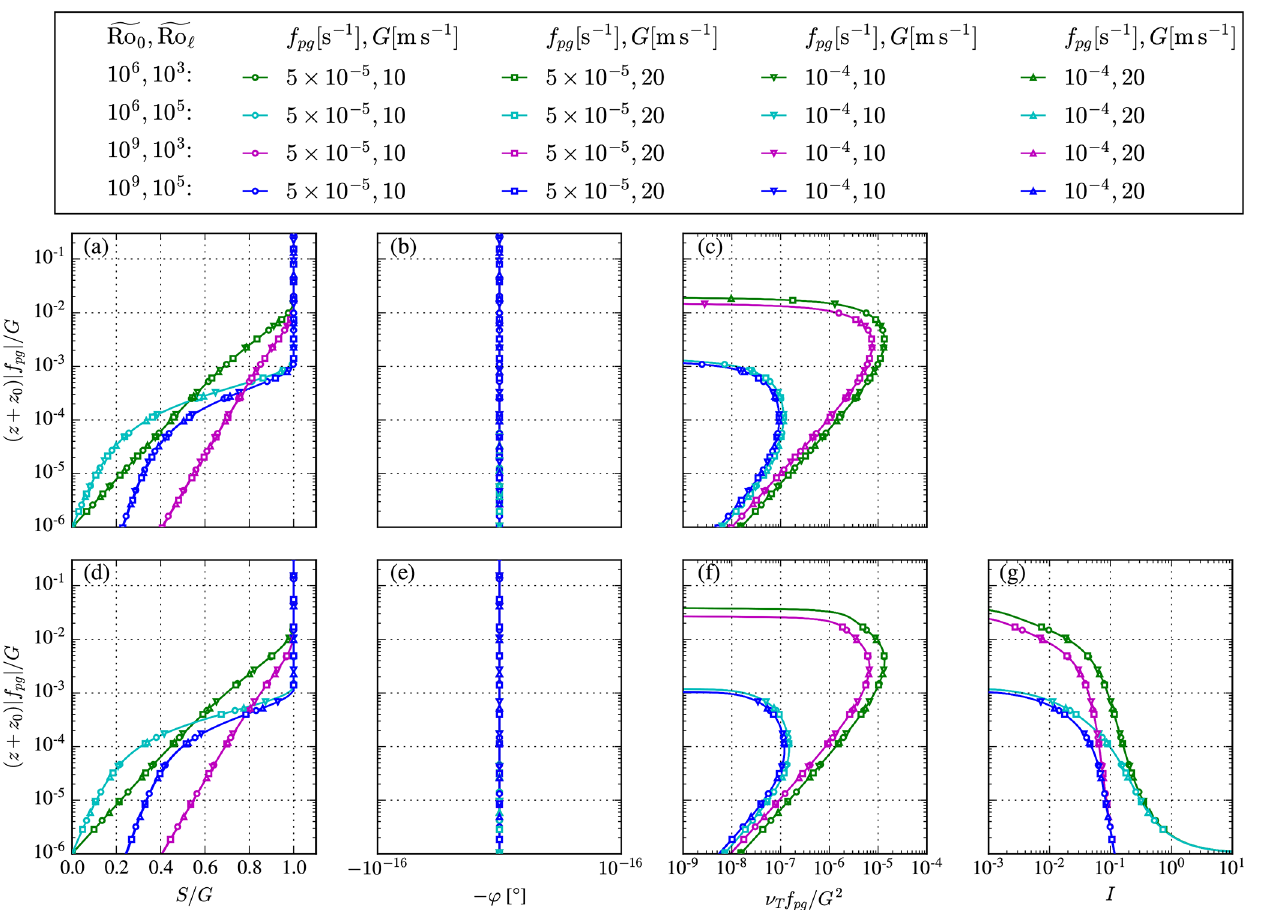
Figure 2. Rossby number similarity of the proposed ABL model without wind veer for two turbulence closures. (a–c) Mixing-length model. (d–g) k – ε